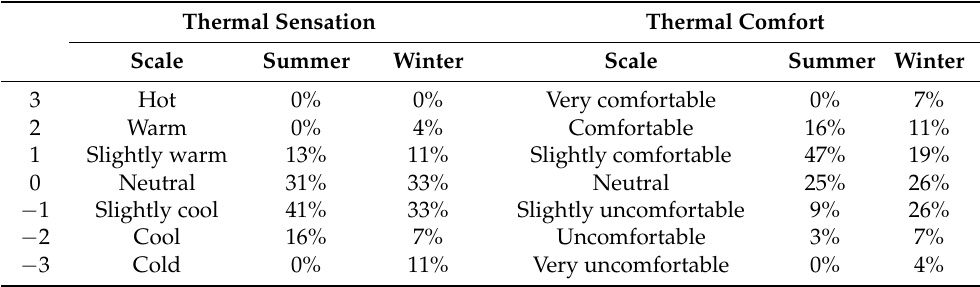
Table 5. Percentage of thermal sensation and comfort in summer and